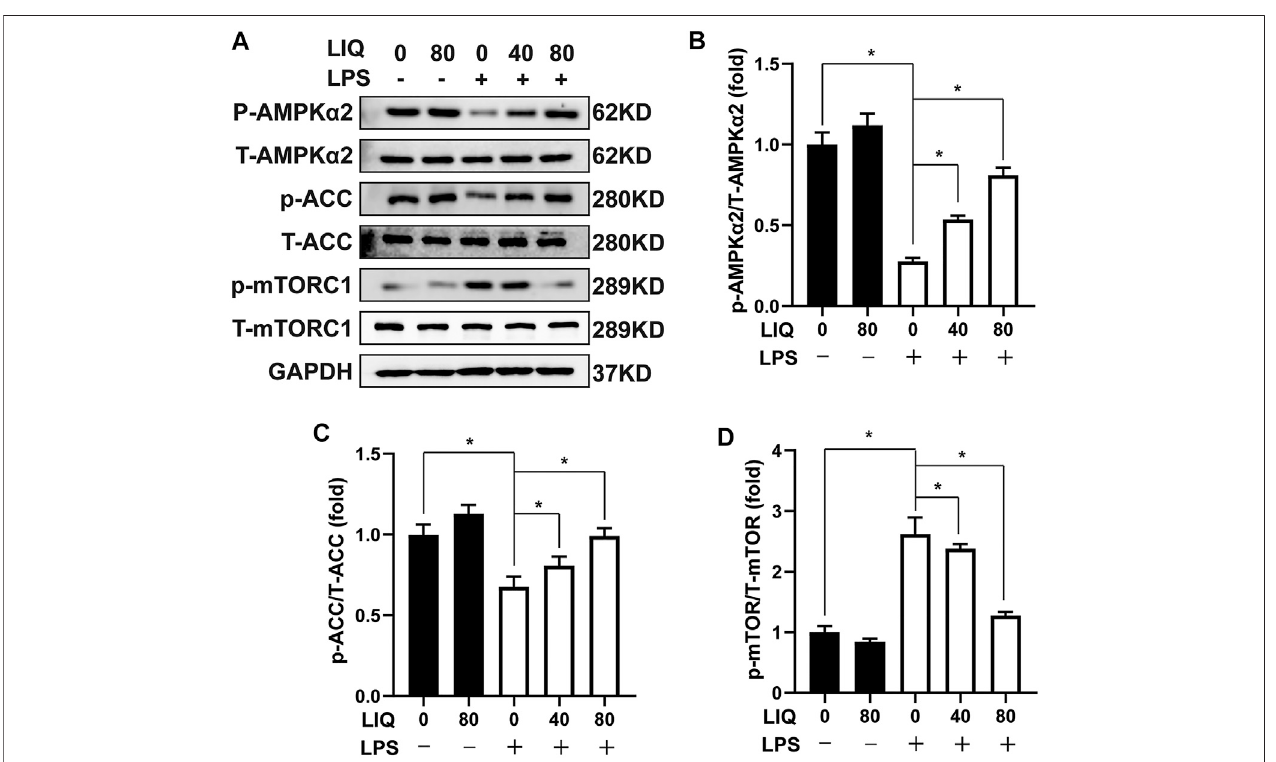
FIGURE 4 | LIQ treatment regulated AMPK α 2/mTOR signaling (A) Representative western blots of phosphorylated AMPK α 2 (p-AMPK α 2), total AMPK α 2 (T-AMPK α 2),p-ACC,T-ACC,p-mTORC1,T-mTORC1andGAPDH,mouseheartswerecollectedforwestern-blotsanalysisaftertreatedwithorwithoutLPS(10 mg/kg) for 12 h ( n (cid:2) 6), relative quantitative of (B) (p-AMPK α 2/T-AMPK α 2), (C) p-ACC/T-ACC and (D) p-mTORC1/T-mTORC1 ( n (cid:2) 6), all of these proteins were normalized to GAPDH before the relative quantitative analysis. * p < 0.05 compared with the indicated group, the data are expressed as the Mean ± SEM and were compared by one-way ANOVA with Tukey post hoc